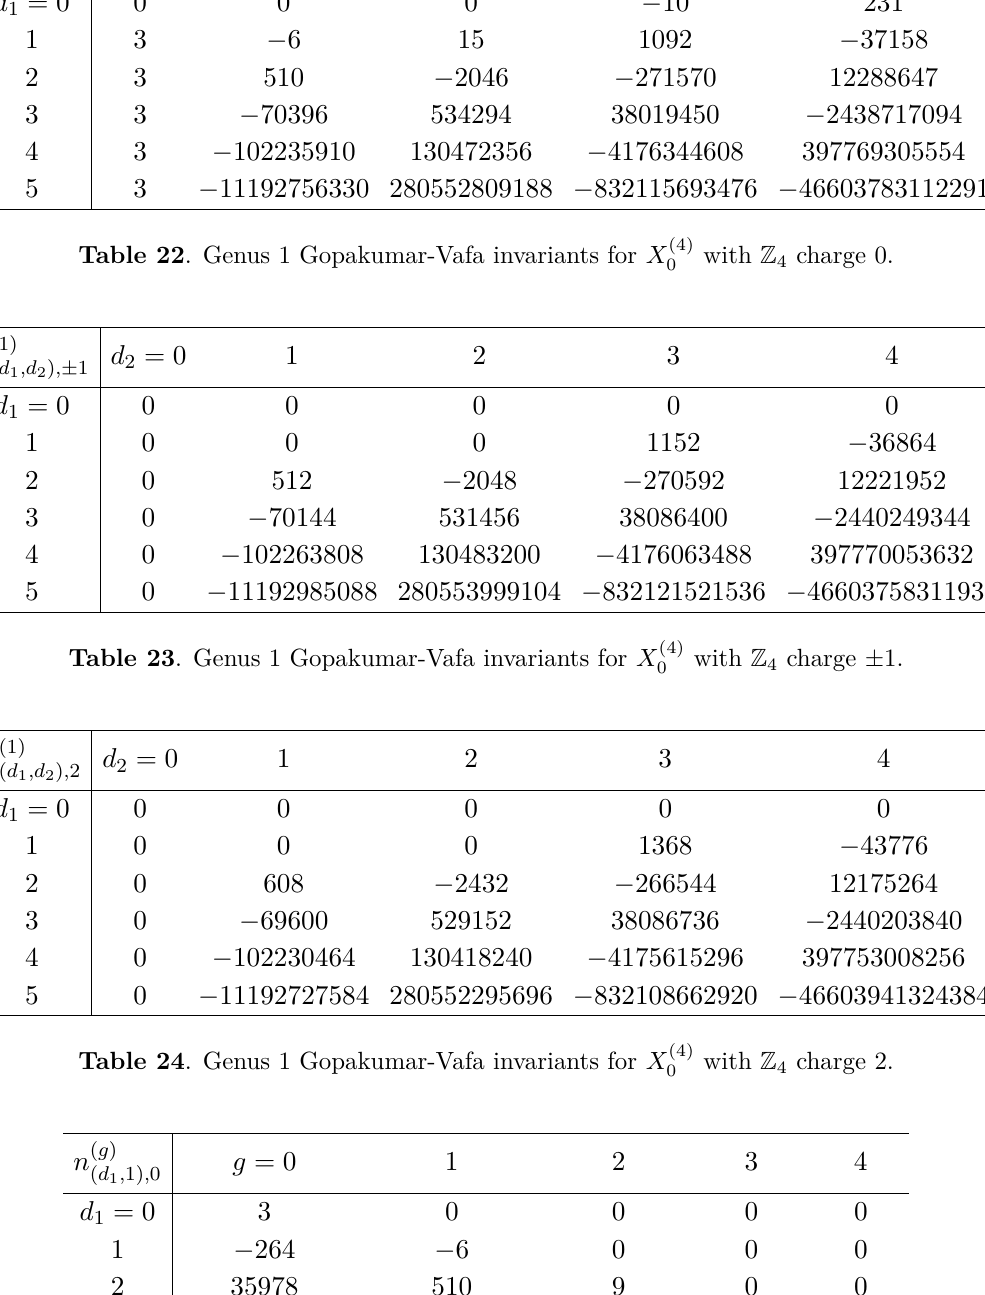
with Z charge 0 4 0